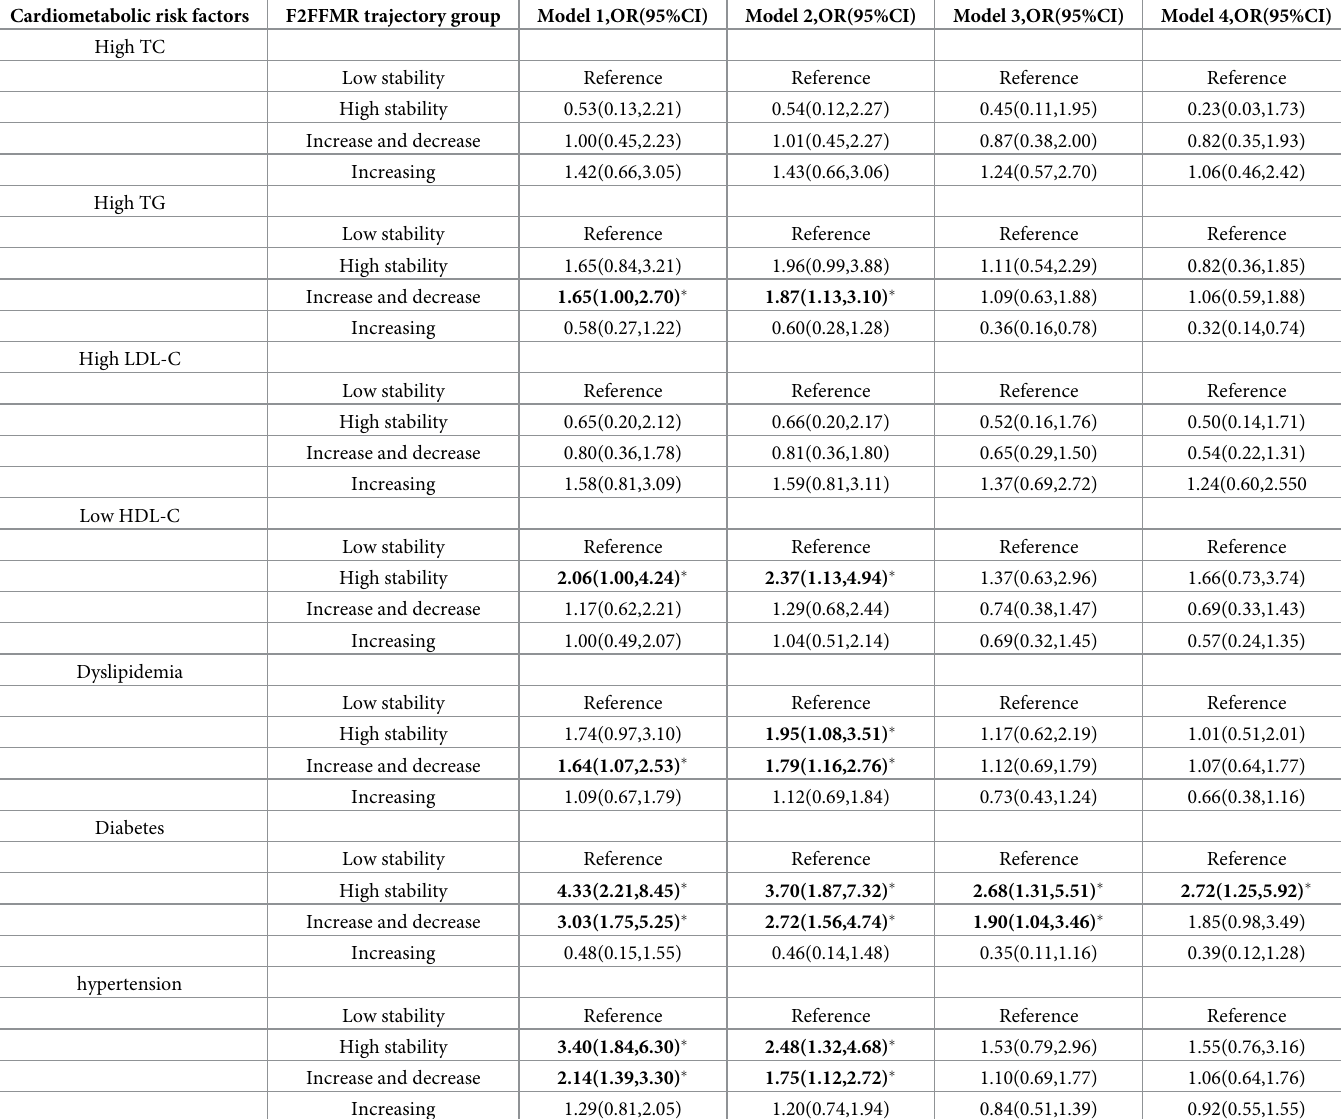
Table 4. ORs and 95% CIs for the associations between the F2FFMR trajectories of men and cardiometabolic risk factors in 2009. Cardiometabolic risk